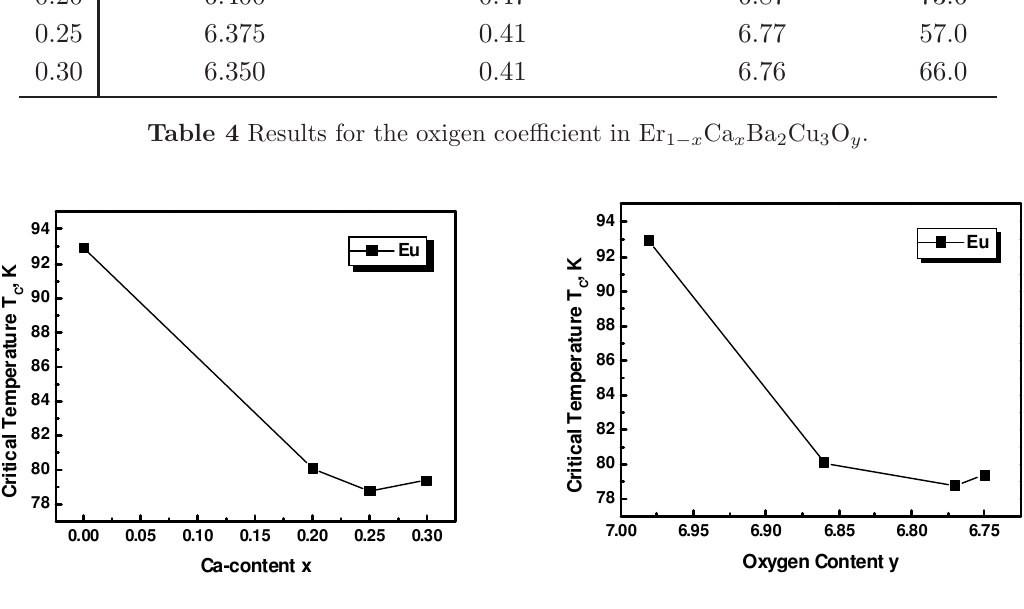
Fig. 2 The critical temperature (T c ) dependence from the Ca-content (x) and the oxygen content (y) in Eu 1 − x Ca x Ba 2 Cu 3 O y .